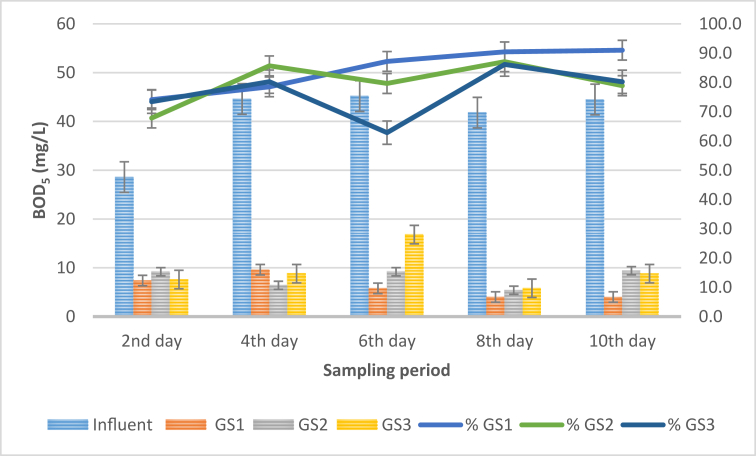
Graph of BOD5 concentrations against sampling period.